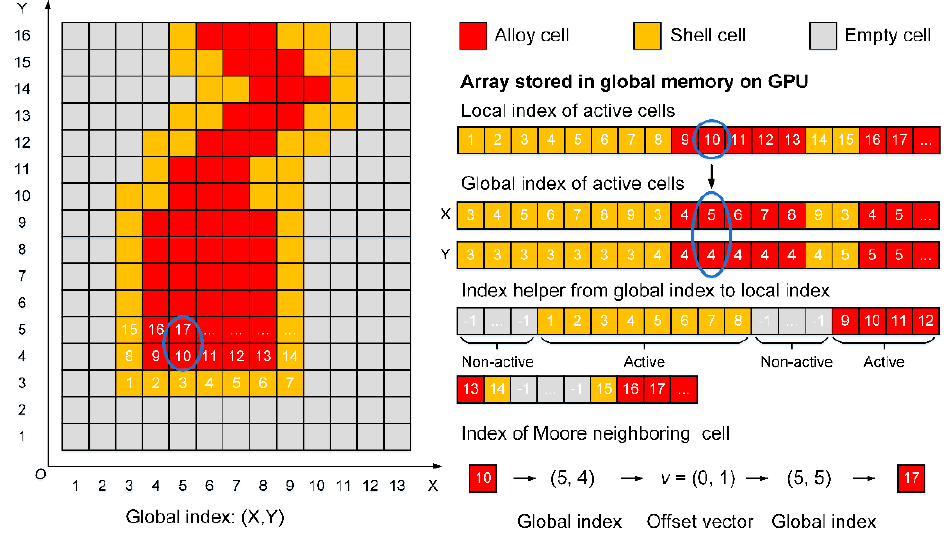
Figure 3. Memory arrangement of CA cells stored on GPU (graphic processing unit).